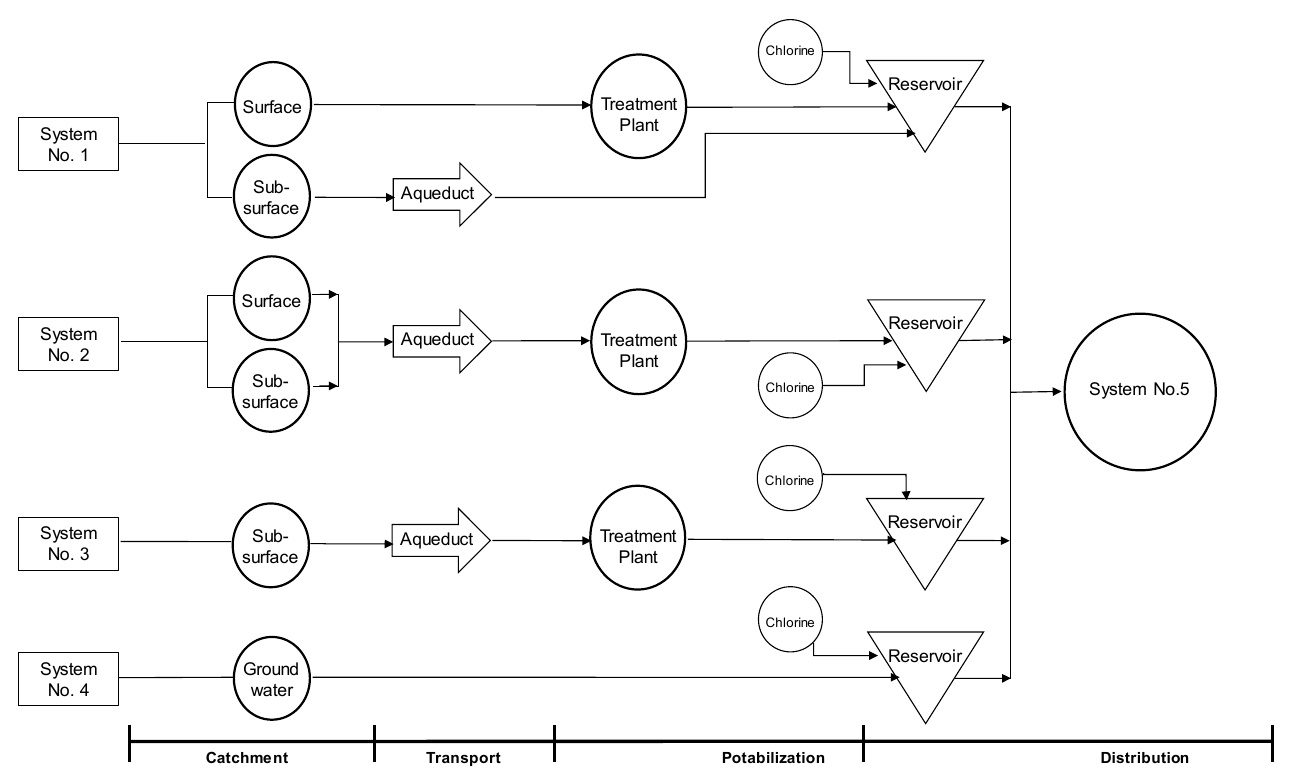
Figure 1. Flow diagram of the water system of the city of Salta. The processes are indicated below the bottom line.